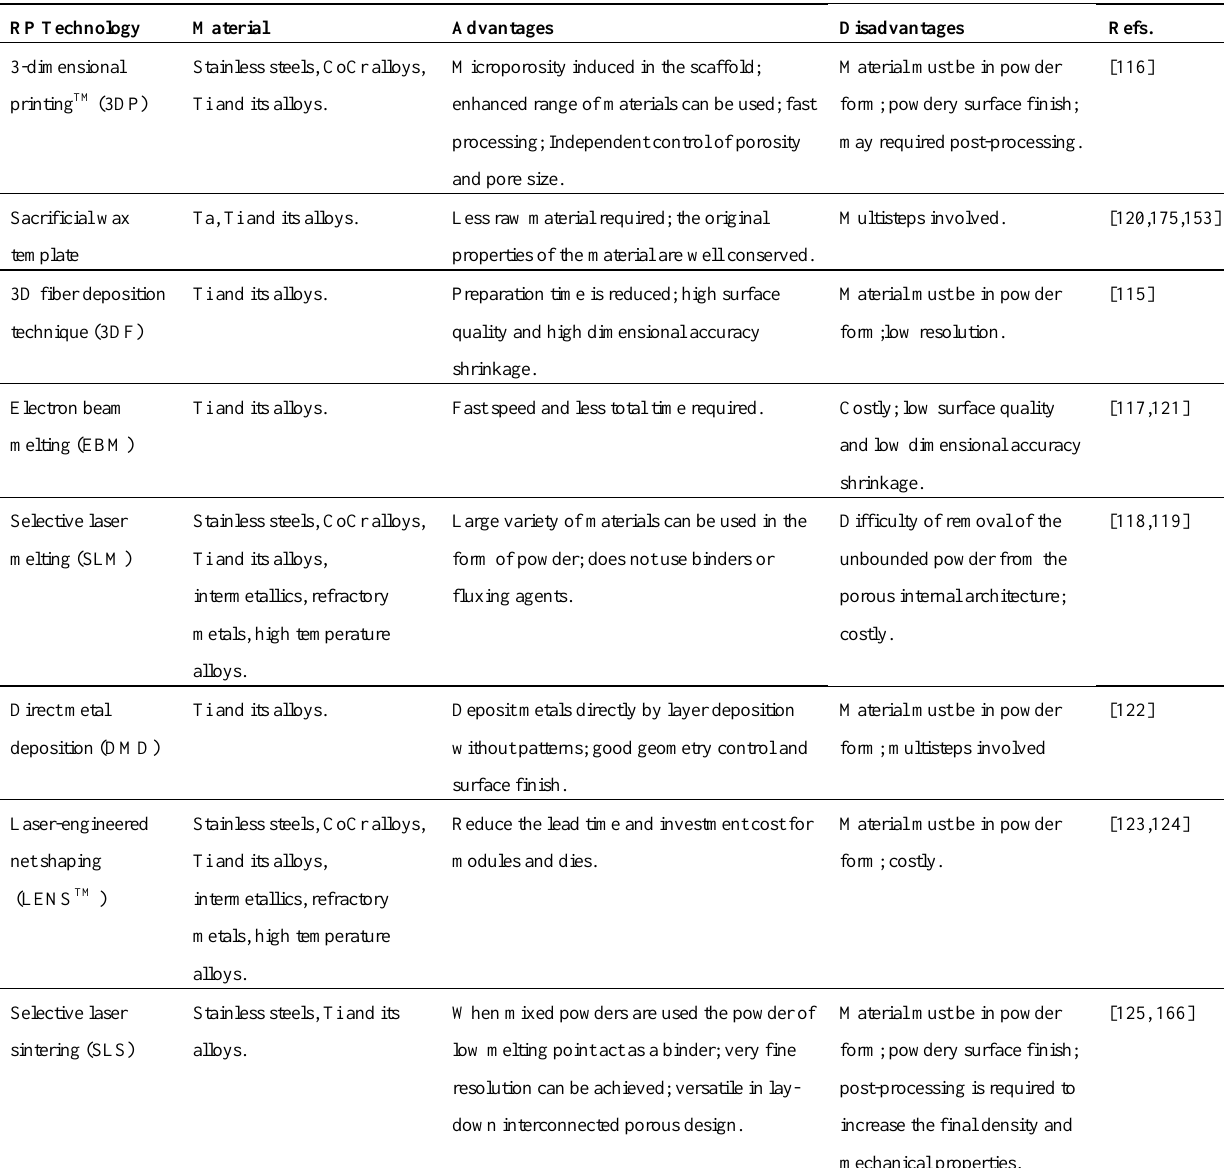
Table 5. Comparison of the different rapid prototyping (RP) technologies available for the fabrication of scaffolds aimed for hard tissue